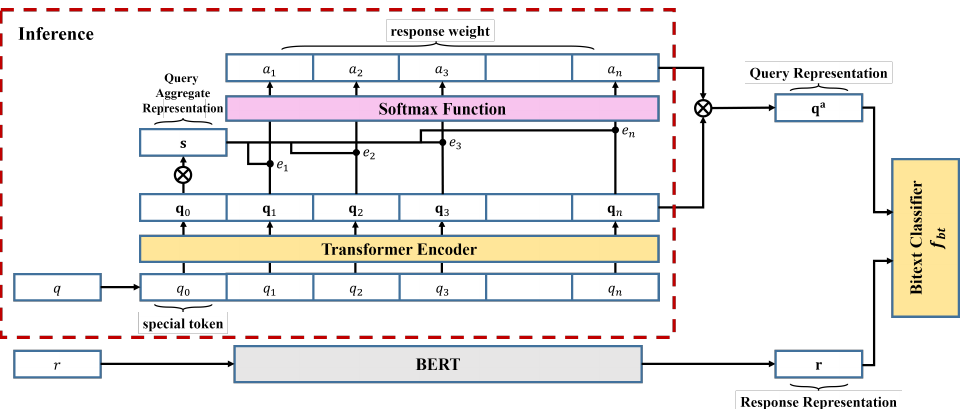
Figure 1. Overall structure for learning the response weight from a pair of a query and a